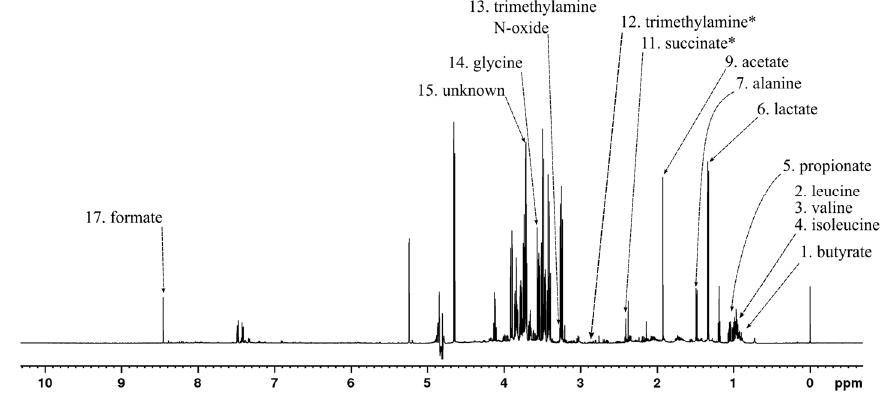
Figure 9. 1 H NMR spectrum of fecal BC culture sample at the 0 h time point after treatment with rugosin D with example signals of the significant metabolites labeled according to Table 1. * Marked metabolite was not visible with used scale in the 0 h sample.